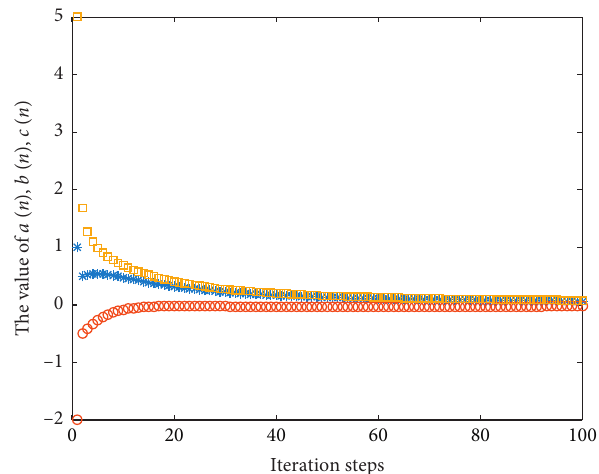
Figure 9: The iterative curves of algorithm (21) under different n